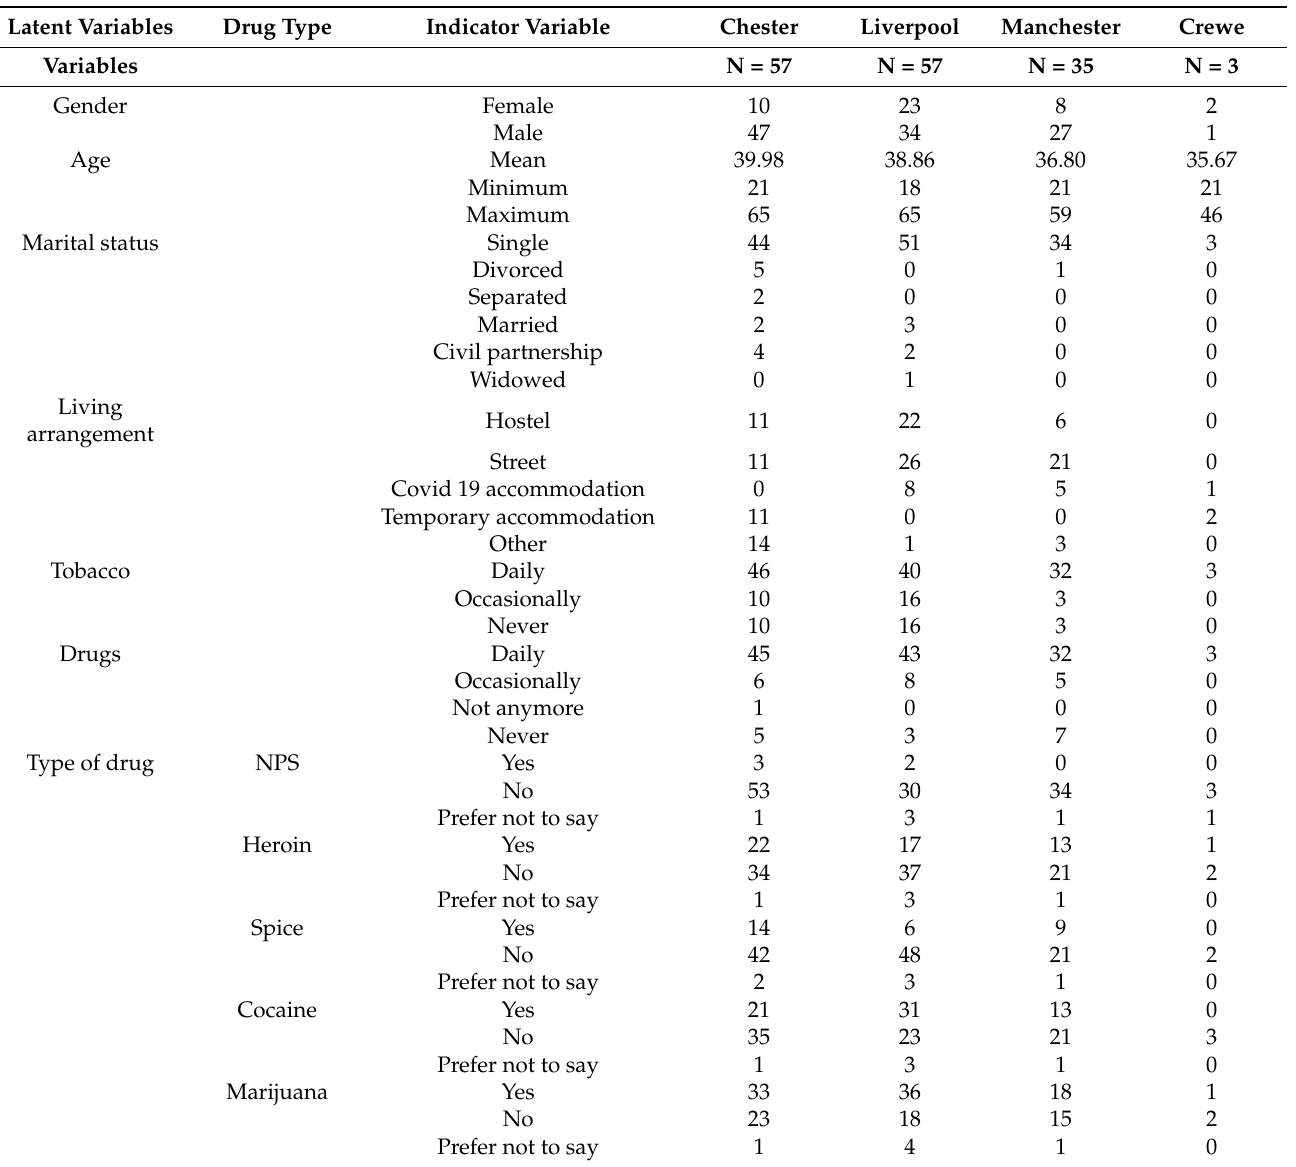
Table 2. Sums of the frequencies of participants’ characteristics, according to location of data